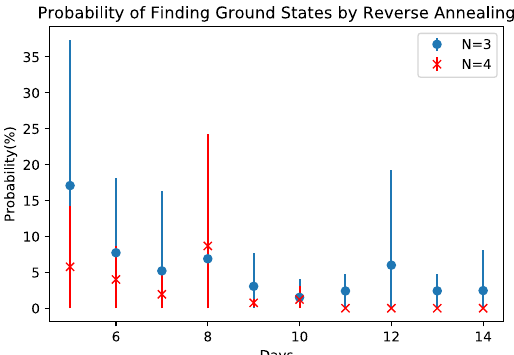
Figure 5. Probability of finding the ground states of the NSP Hamiltonian by reverse annealing. Each error bar is generated by the standard deviation (1000 samples times 10 shots for each problem).